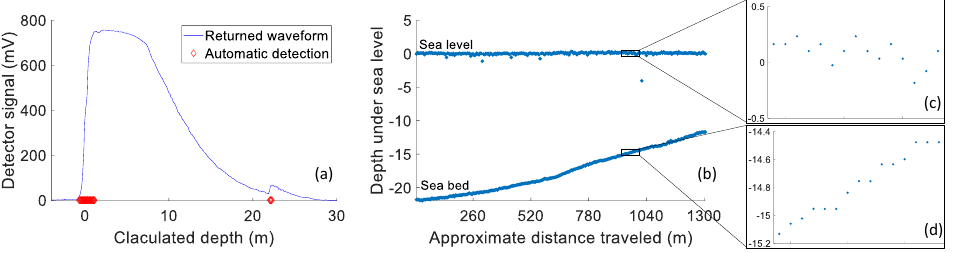
Figure 3. ( a ) Raw waveform data as measured by the SiPM detector, with detected object ranges. ( b ) Detected return signals from the sea’s surface and the seabed. The signal from the surface is highly variable due to waves, while the seabed’s depth changes slowly as the boat sail toward the shore. ( c ) Zoom-in example of the sea level which reveals waves of up to 40 cm change in sea level. ( d ) Zoom-in example of the seabed signal, corresponding to the sea level signal in ( c ). No correlations are seen between the two